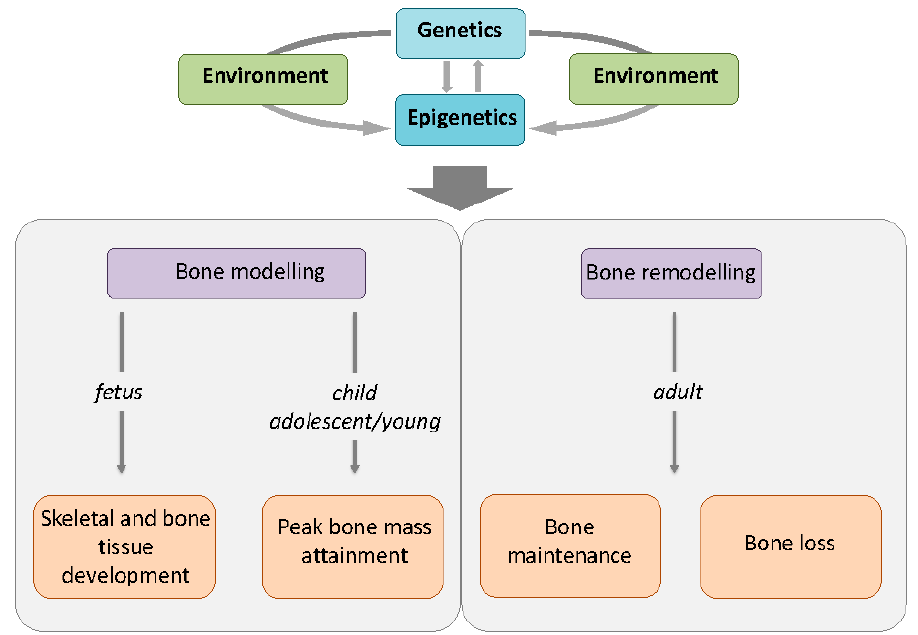
Figure 2. Schematic representation of the role of genetics and epigenetics in bone development and maintenance. Static genetic traits and dynamic epigenetic marks interact with inner and outer environmental stimuli to determine bone features at all ages. While genetics may modulate the expression of epigenetics marks, epigenetic markers can regulate the expression of many genes coding for key molecules driving skeletal modelling in growing bone and remodelling in adult bone. Thus, all processes from bone development to peak bone mass attainment and maintenance can be influenced by epigenetic signatures, implying the possibility of modulating epigenetics in order to prevent/treat bone deterioration.